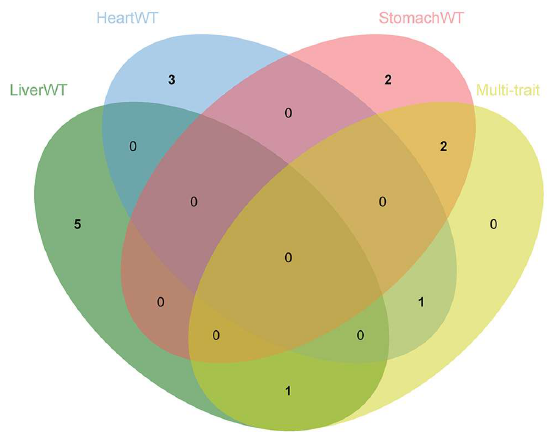
Figure 4. Manhattan plots of multi-trait GWAS results for six internal organ weight traits in the DLY population. The x -axis represents the chromosome, and the y -axis represents the − log10 ( p -value) value in the Manhattan plot of the GWAS. The dashed line indicates the FDR-corrected threshold.